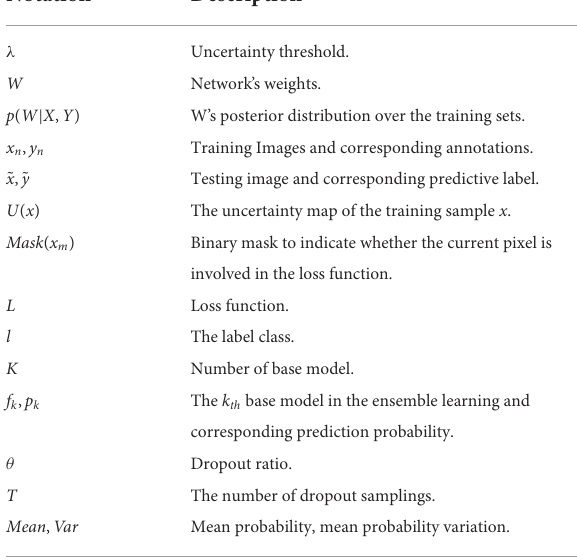
TABLE 1 Notations used in the